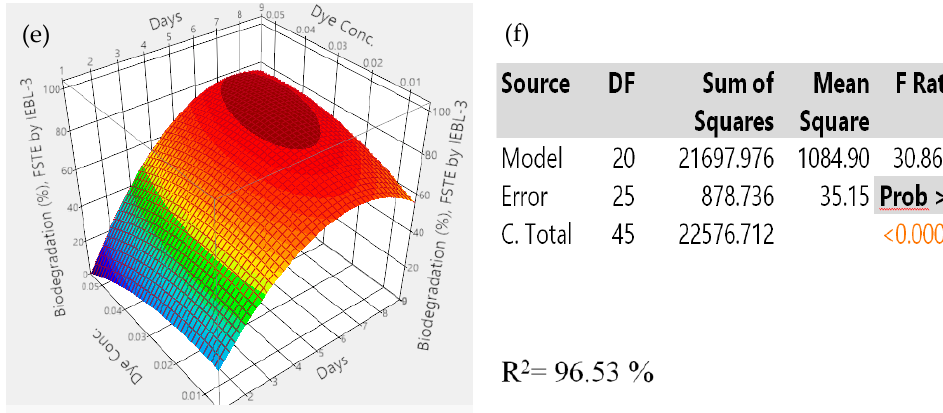
Figure 2. The 3D response surface graphs of the interaction between parameters during the bio-degradation of FST industrial effluent by P. betulinus IEBL-3; there is positive interaction between ( a )—pH and time ( b )—pH and temp. ( c )—size of inoculum and time ( d )—size of inoculum and dye conc. ( e )—time and dye conc. ( f )—statistical analysis (* indicate significance of value). During the current study, there was 67.10 ± 1.2% bio-degradation of ST industrial effluent obtained. The most favorable conditions were pH 5.4, time of 08 days, size of inoculum 6.06 mL, temperature 26.90 °C and dye concentration 0.04%. The analysis of 3D graphs indicated that the maximum biodegradation achieved was the result of the positive and combinatorial effect of all five parameters (Figure 3). The significant effect of all parameters on the process of biodegradation of ST effluent was confirmed by the statistical analysis and indicated by a low p value ( p > 0.001), high F. ratio (32.42) and high R 2 value (R 2 = 96.50%) [3].